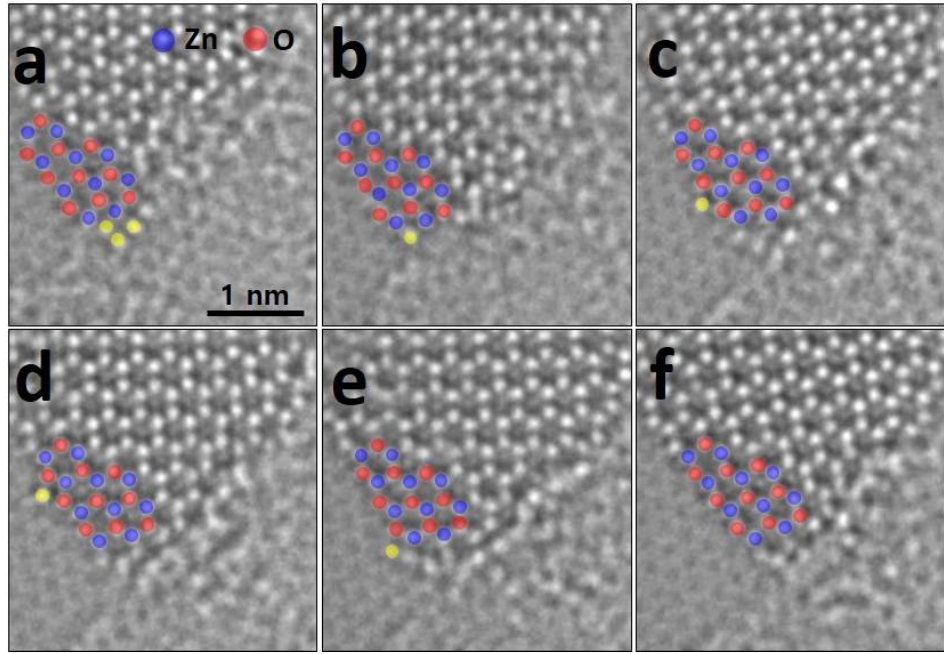
Figure 3. Atomic migration at the edge of the monolayer g-ZnO sheet. ( a , b ) successive images show- ing migrating adatoms, colored by yellow dots. ( c – e ) The adatom moves on top of dips in the ZZ configuration at the edge. ( f ) The adatom is finally detached.